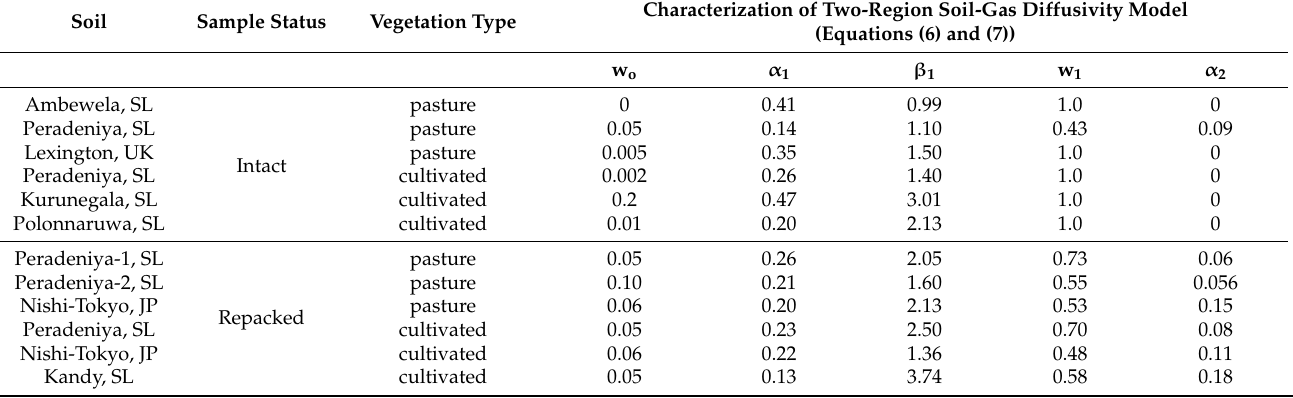
Table 5. Numerical parameterization of two-region soil-gas diffusivity model (Equations (6) and (7)) for pasture and cultivated